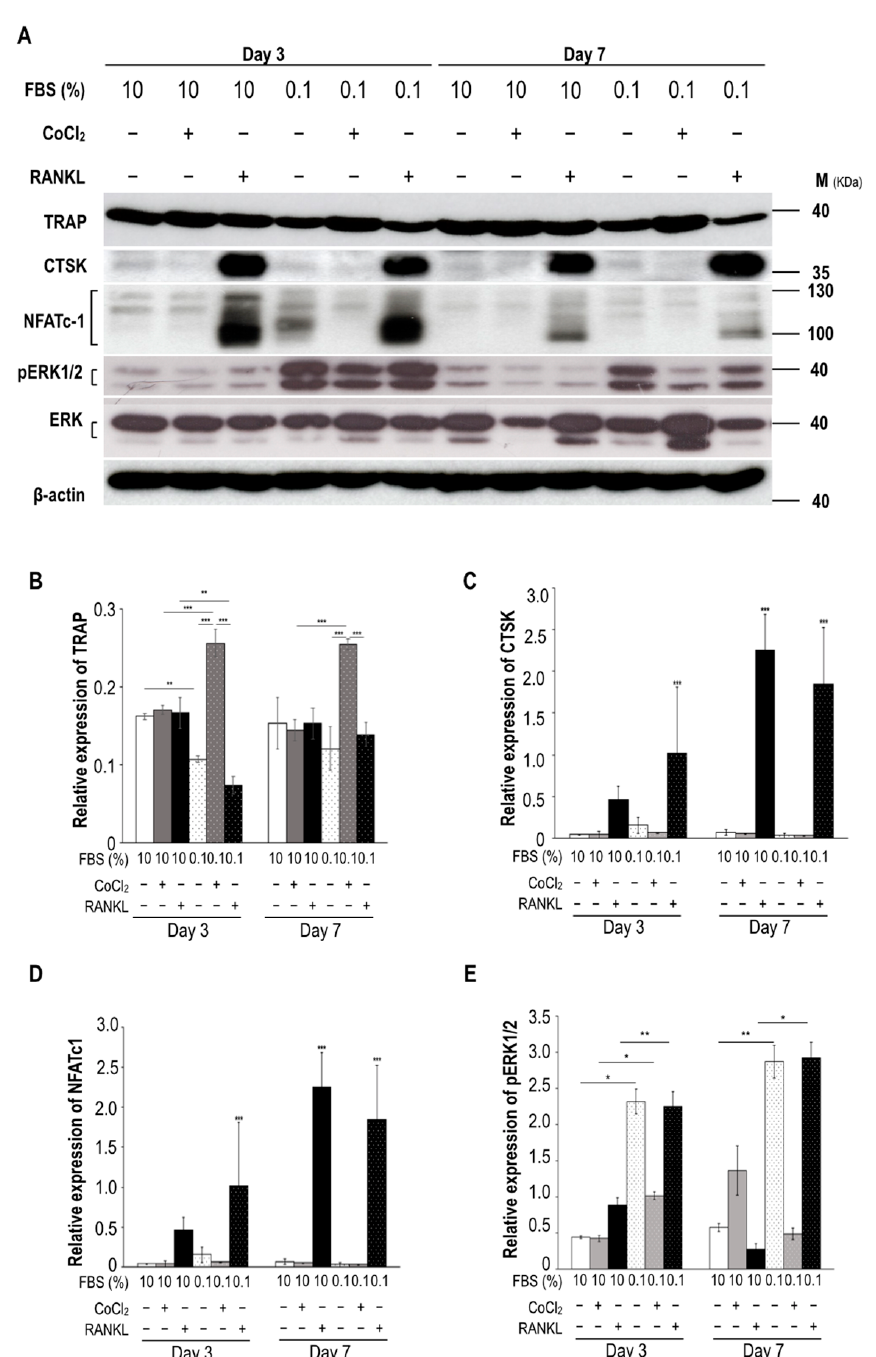
Figure 2. Expression of osteoclast markers subject to stress. ( A ) Immunoblotting was used to detect marker proteins in RAW264.7 lysates. Antibodies of TRAP, CTSK, NFATc1, and pERK1/2 were used to detect osteoclast expression after different treatments. Quantification results are also displayed for ( B ) TRAP, ( C ) CTSK, ( D ) NFATc1, and ( E ) pERK1/2. The identities of the level of TRAP, CTSK, and NFATc1 proteins were normalized to the level of β -actin; pERK1/2 was normalized to the total ERK1/2 protein level. Brackets indicate isoforms of NFATc1 (from 90 to 140 KDa) and ERK1/2 (44 and 42 KDa) in RAW264.7 cells. The identity of NFATc-1 is the combination of three isoforms. All data are presented as the mean ± SD ( n = 3); asterisks at the tops of the bars indicate significant differences (* p < 0.05, ** p < 0.01, *** p < 0.001). Abbreviations: FBS, fetal bovine serum; CTSK, cathepsin K; NFATc1, nuclear factor of activated T-cells cytoplasmic 1; pERK1/2, phosphorylated extracellular-regulated kinase 1/2; TRAP, tartrate-resistant acid